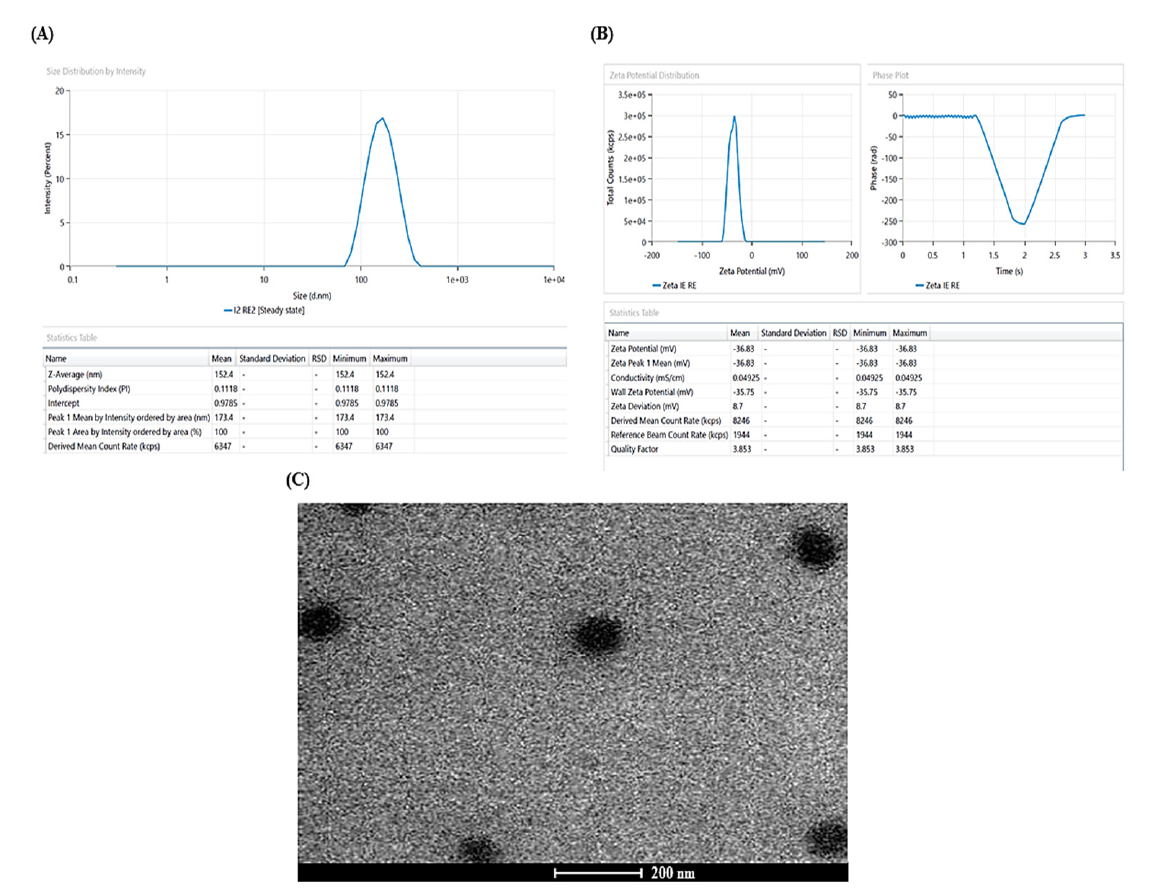
Figure 3. ( A ) Vesicle size distribution of PIP − SPLopt formulation, ( B ) zeta − potential of PIP − SPLopt formulation, and ( C ) transmission electron microscopy of PIP − SPLopt formulation.